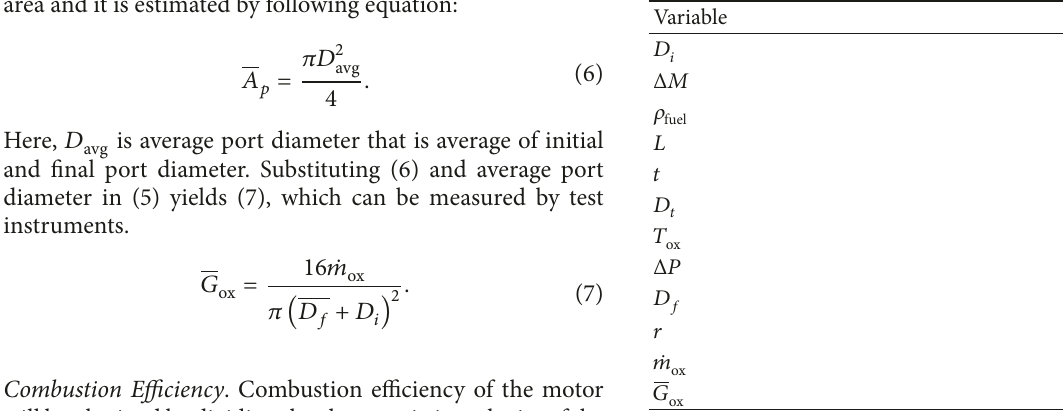
Table 1: Relative errors of test